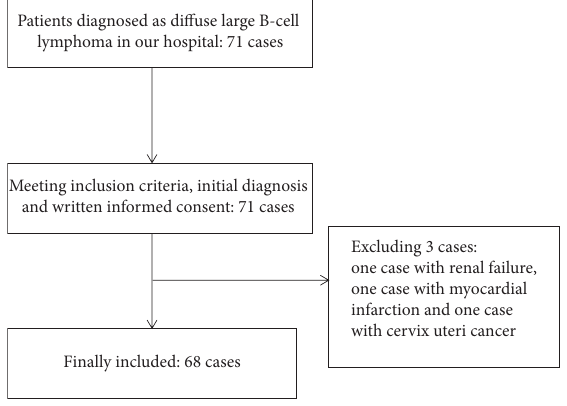
Figure 1: Flowchart of patients’